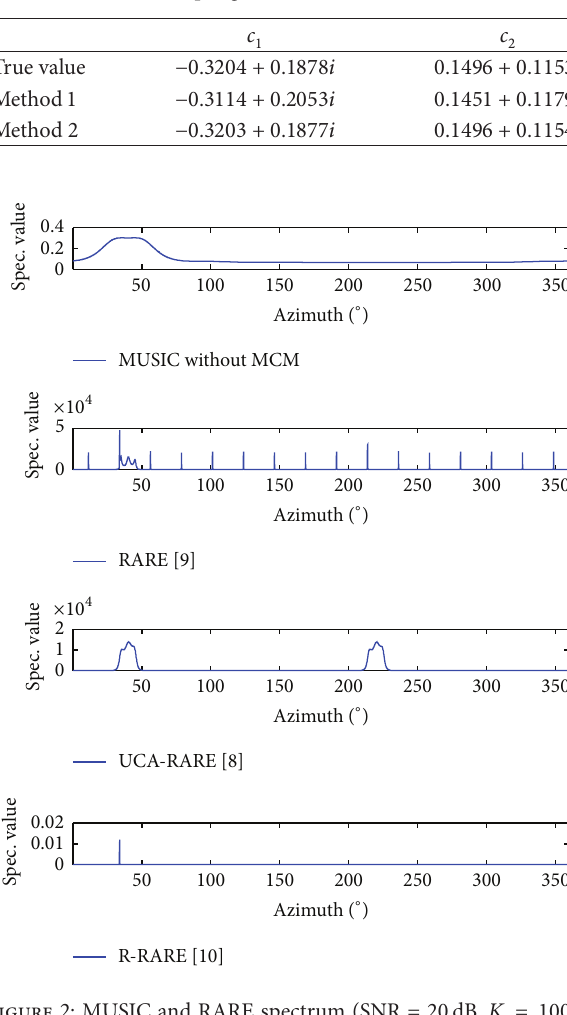
Figure 2: MUSIC and RARE spectrum (SNR = 20 dB, 𝐾 = 1000